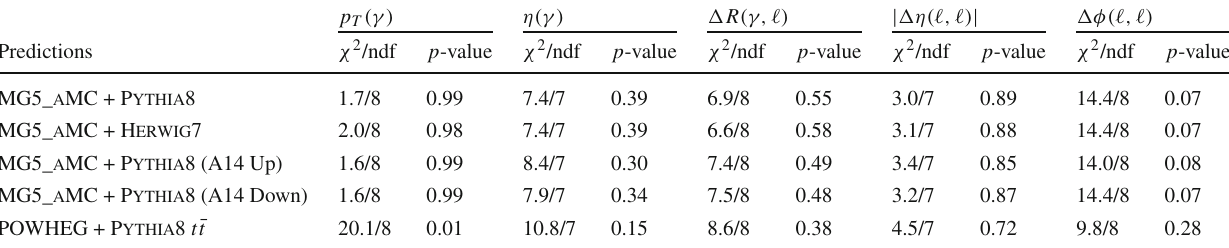
Table 8 χ 2 /ndf values and p -values between the measured normalized differential cross-sections and predictions from several generators in the dilepton